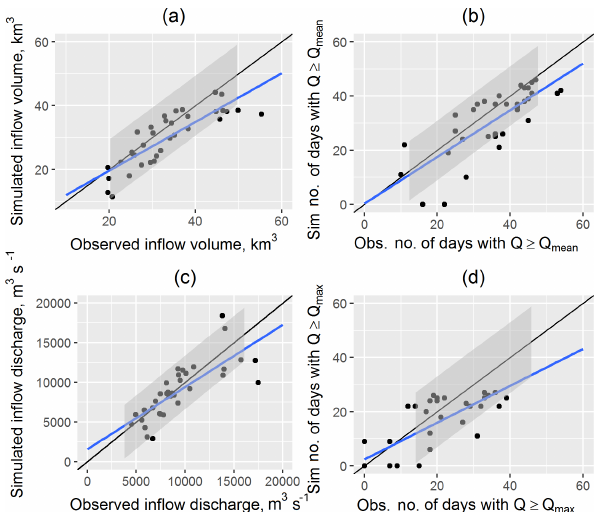
Figure 3. Scatterplots for the observed and simulated characteris- tics of inflow into the Cheboksary Reservoir during April–June: volume W (a) , the number of days above the mean inflow dis- charge N q (b) , the maximum discharge Q max (c) and the number of days above the mean maximum inflow discharge N q blue line represents the linear fit. The black line represents the per- fect fit. The grey shaded area denotes the variance band of ± 1SD (standard deviation) of the respective observed